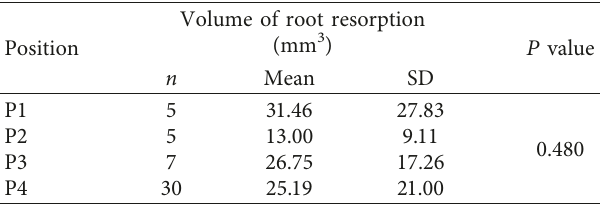
Table 2: Comparison of the MVR in terms of canine position in the mesiodistal